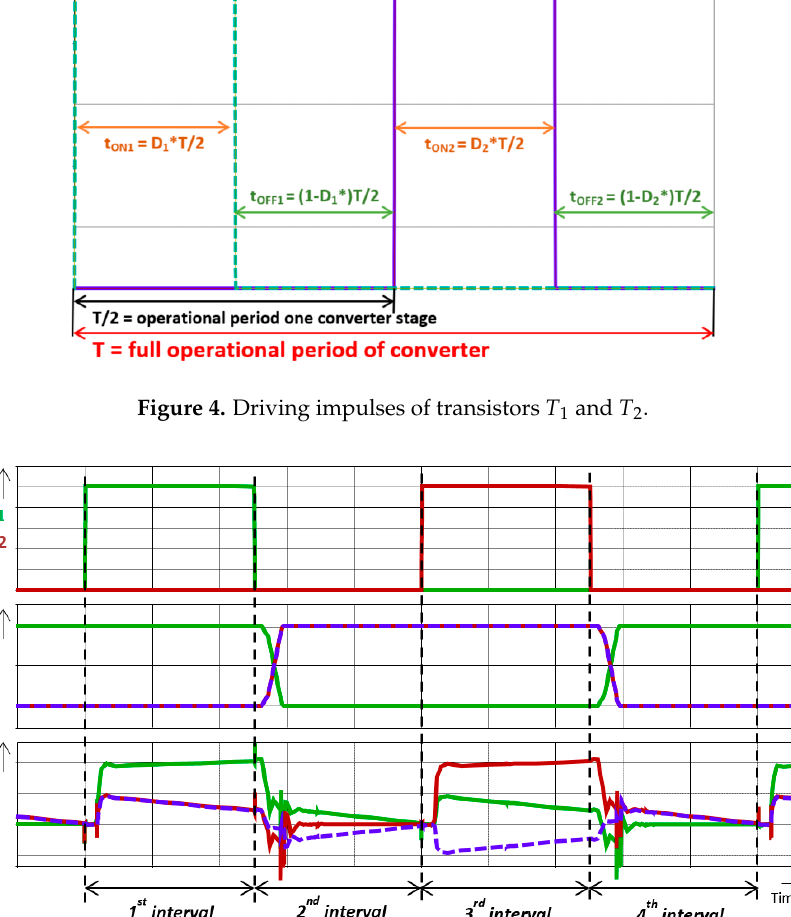
Figure 5. Operational waveforms for analyzed steady state of proposed converter—nominal load ( top : driving signals, middle : voltages on inductors, bottom : inductor currents).